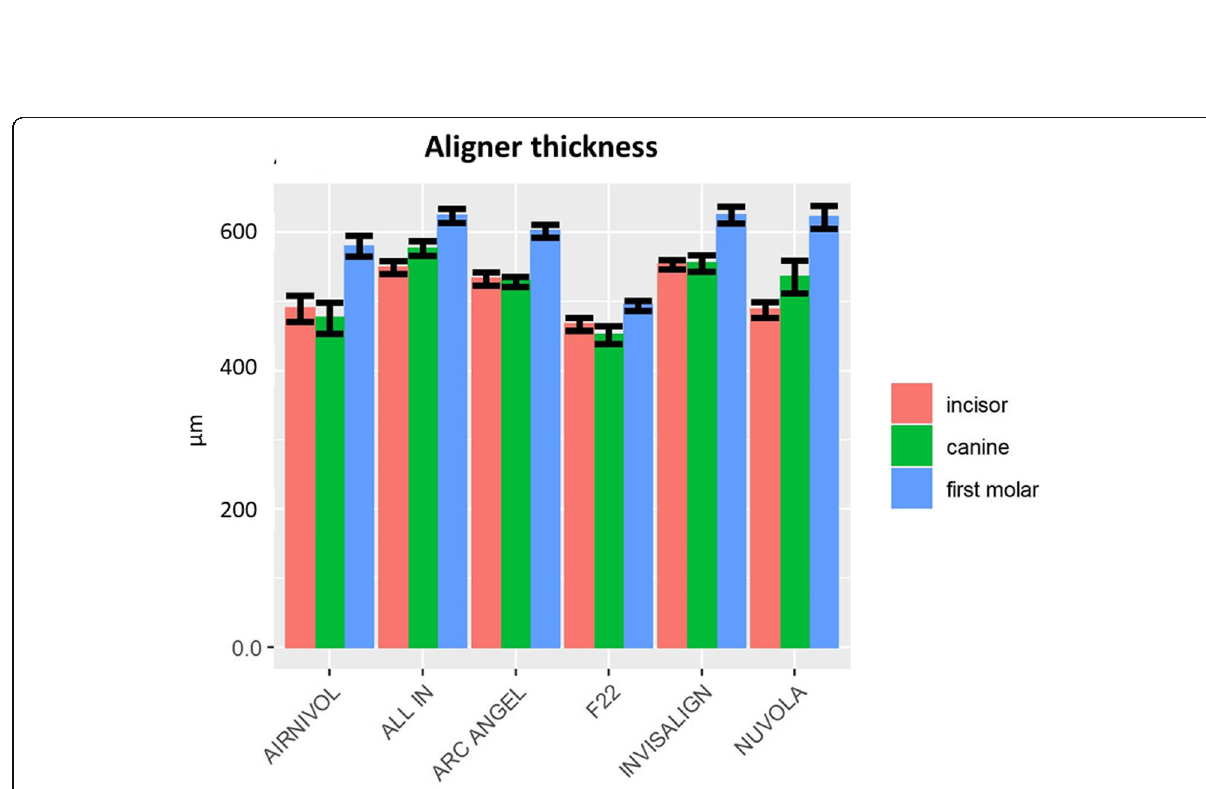
Fig. 8 Graphical representation of aligner thickness values and